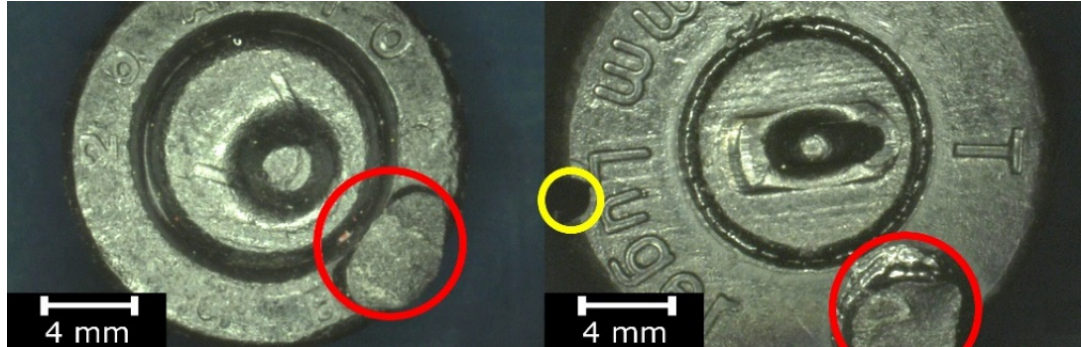
Figure 2. Mark left by the removed gating channel on the surface of the replica (indicated in red) and casting defects (indicated in yellow).